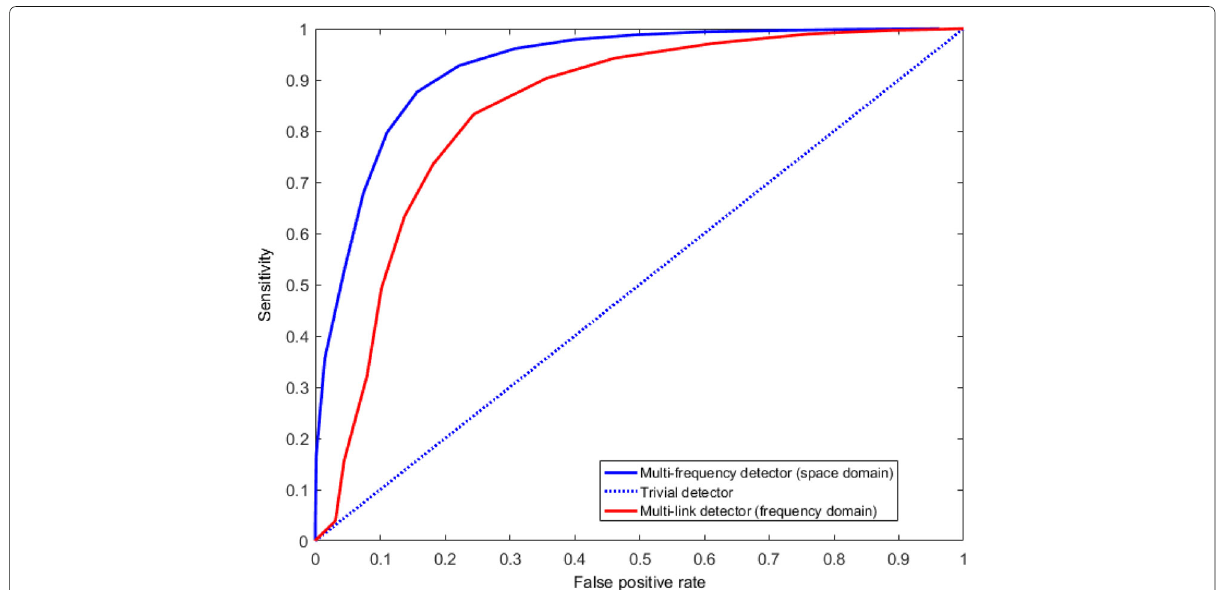
Fig. 8 ROC results using the multi-frequency occupancy detector (that exploits spatial correlations), the multi-link occupancy detector (that uses frequency correlations), and the trivial detector. The measurements adopted for these plots are related to the double target scenario where the bodies move along the main LOS path (connecting TX and RX2)